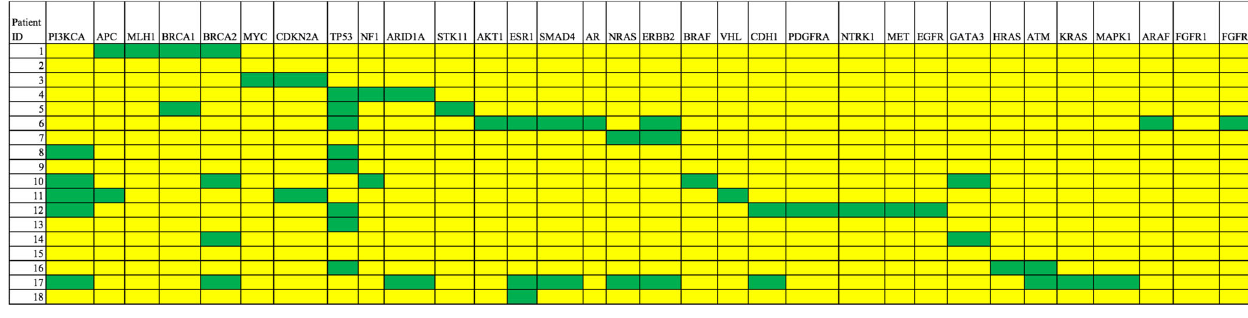
Fig. 3 Cell-free DNA mutation spectrum in individual patients with BM. A statistically signi fi cant higher prevalence of APC , BRCA2 , CDKN2A , and SMAD4 mutations were seen in BM vs